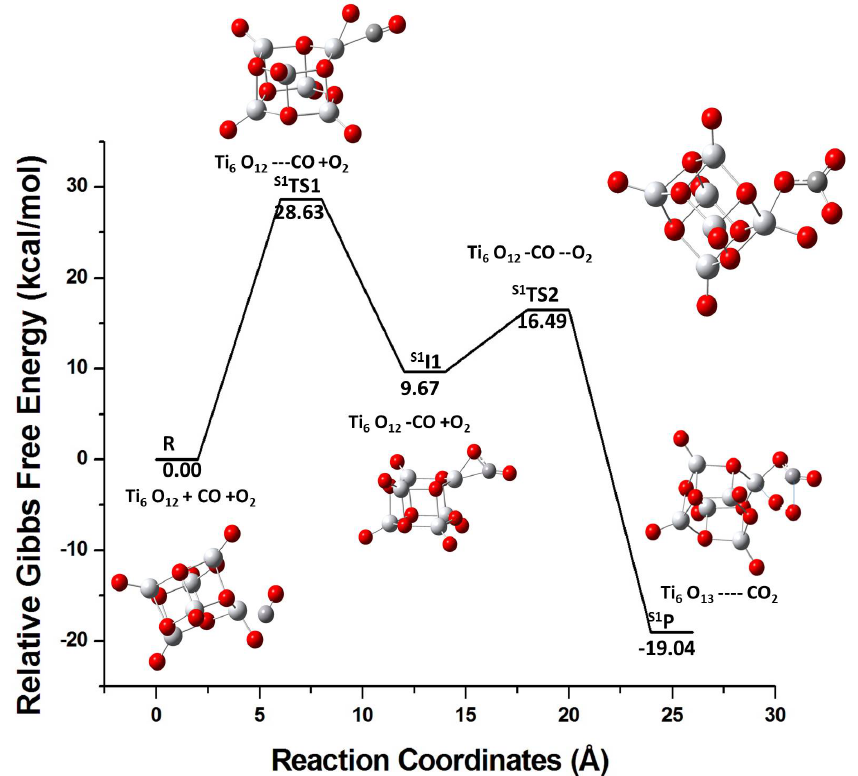
Figure 3. The relative free energy profile for the reaction of the S1 isomer with CO followed by a reaction with the O 2 molecule. R , S 1 TS1, S 1 I1, S 1 TS2, and S 1 P represent reactants, transition state 1, intermediate state 1, transition state 2, and product,